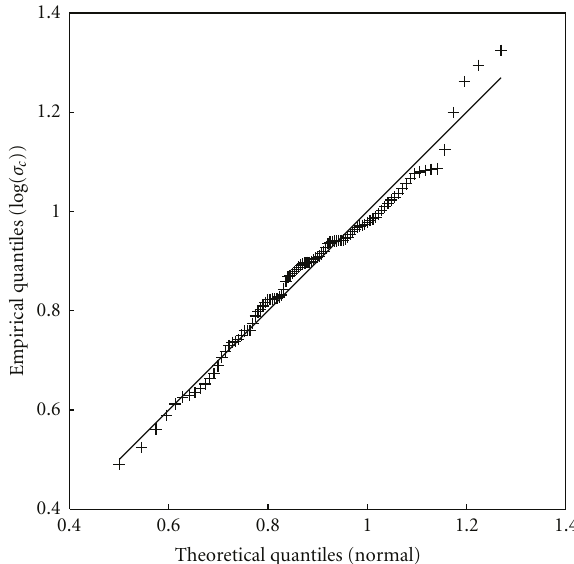
Figure 9: QQ plot of quantiles of log( σ c ) versus quantiles of a normal